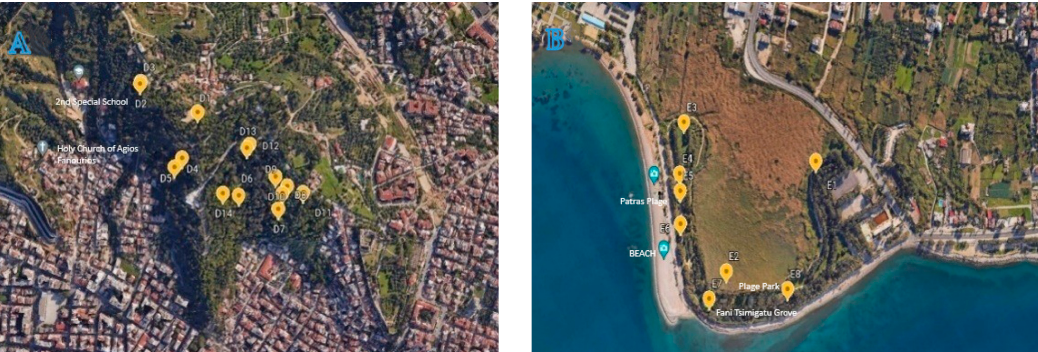
Figure 1. Suburban areas in the prefecture of Achaia where the soil samples were collected ( A ) DASYLIO (38 ◦ 24 (cid:48) 90.209 (cid:48)(cid:48) N, 21 ◦ 74 (cid:48) 56.985 (cid:48)(cid:48) E) and ( B ) ELOS (38 ◦ 27 (cid:48) 99.487 (cid:48)(cid:48) N, 21 ◦ 74 (cid:48) 7.156 (cid:48)(cid:48)